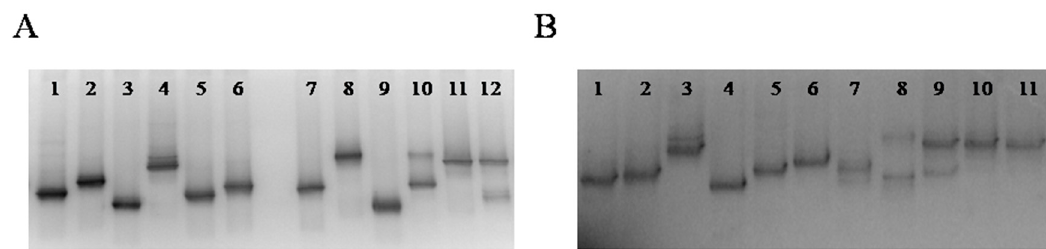
Figure 6. Bacterial DGGE profiles of nucleic acids extracted directly from sourdough samples. ( A ): DNA. Lane 1, Lb. brevis ; Lane 2, Lb. plantarum ; Lane 3, Cb. paralimentarius ; Lane 4, Fb. sanfranciscensis ; Lane 5, Lb.zymae ; Lane6, Lb. sakei ; Lane7, Lb. curvatus ; Lane8, Lc. lactis ; Lane9, Ln.citreum ; Lane10, Ln.mesenteroides ; Lane 11, Sourdough 3; Lane 12, Sourdough 2; ( B ): RNA. Lane 1, Lb. sakei ; Lane 2, Lb. curvatus ; Lane 3, Fb. sanfranciscensis ; Lane 4, Cb. paralimentarius ; Lane 5, Lb. brevis ; Lane 6, Lb. plantarum 2; Lane 7, Lb. zymae ; Lane 8, Sourdough 13; Lane 9, Sourdough 5; Lane 10, Sourdough 7; Lane 11, Sourdough